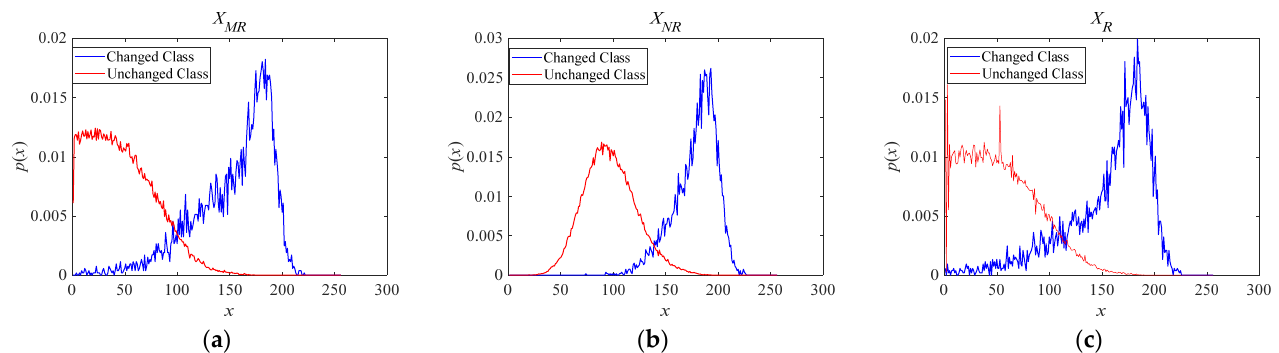
Figure 2. Histograms of opposite class pixels for various difference images obtained by ( a ) mean-ratio detector ( b ) neighborhood-based ratio operator and ( c ) ratio operator.